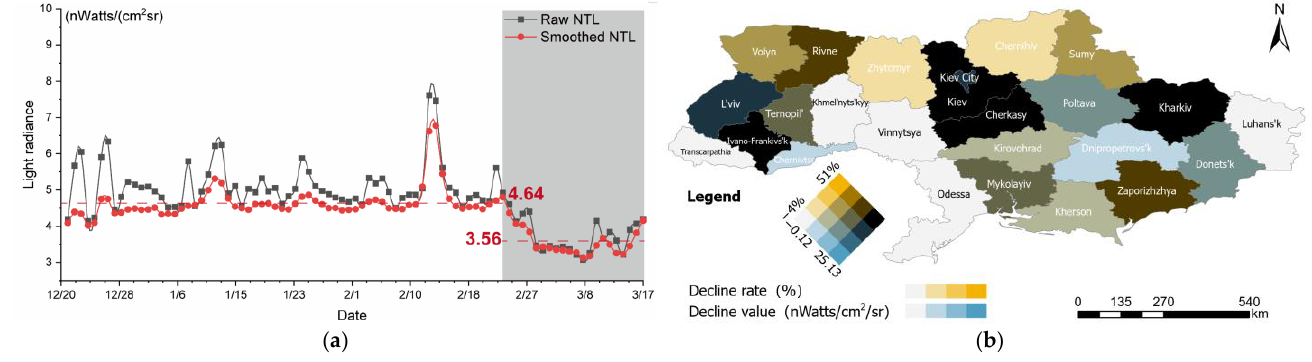
Figure 3. ( a ) Daily mean light radiation curve of Ukraine on the national scale (gray background represents the period of conflict); ( b ) The rate and magnitude of light decay at the oblast scale.